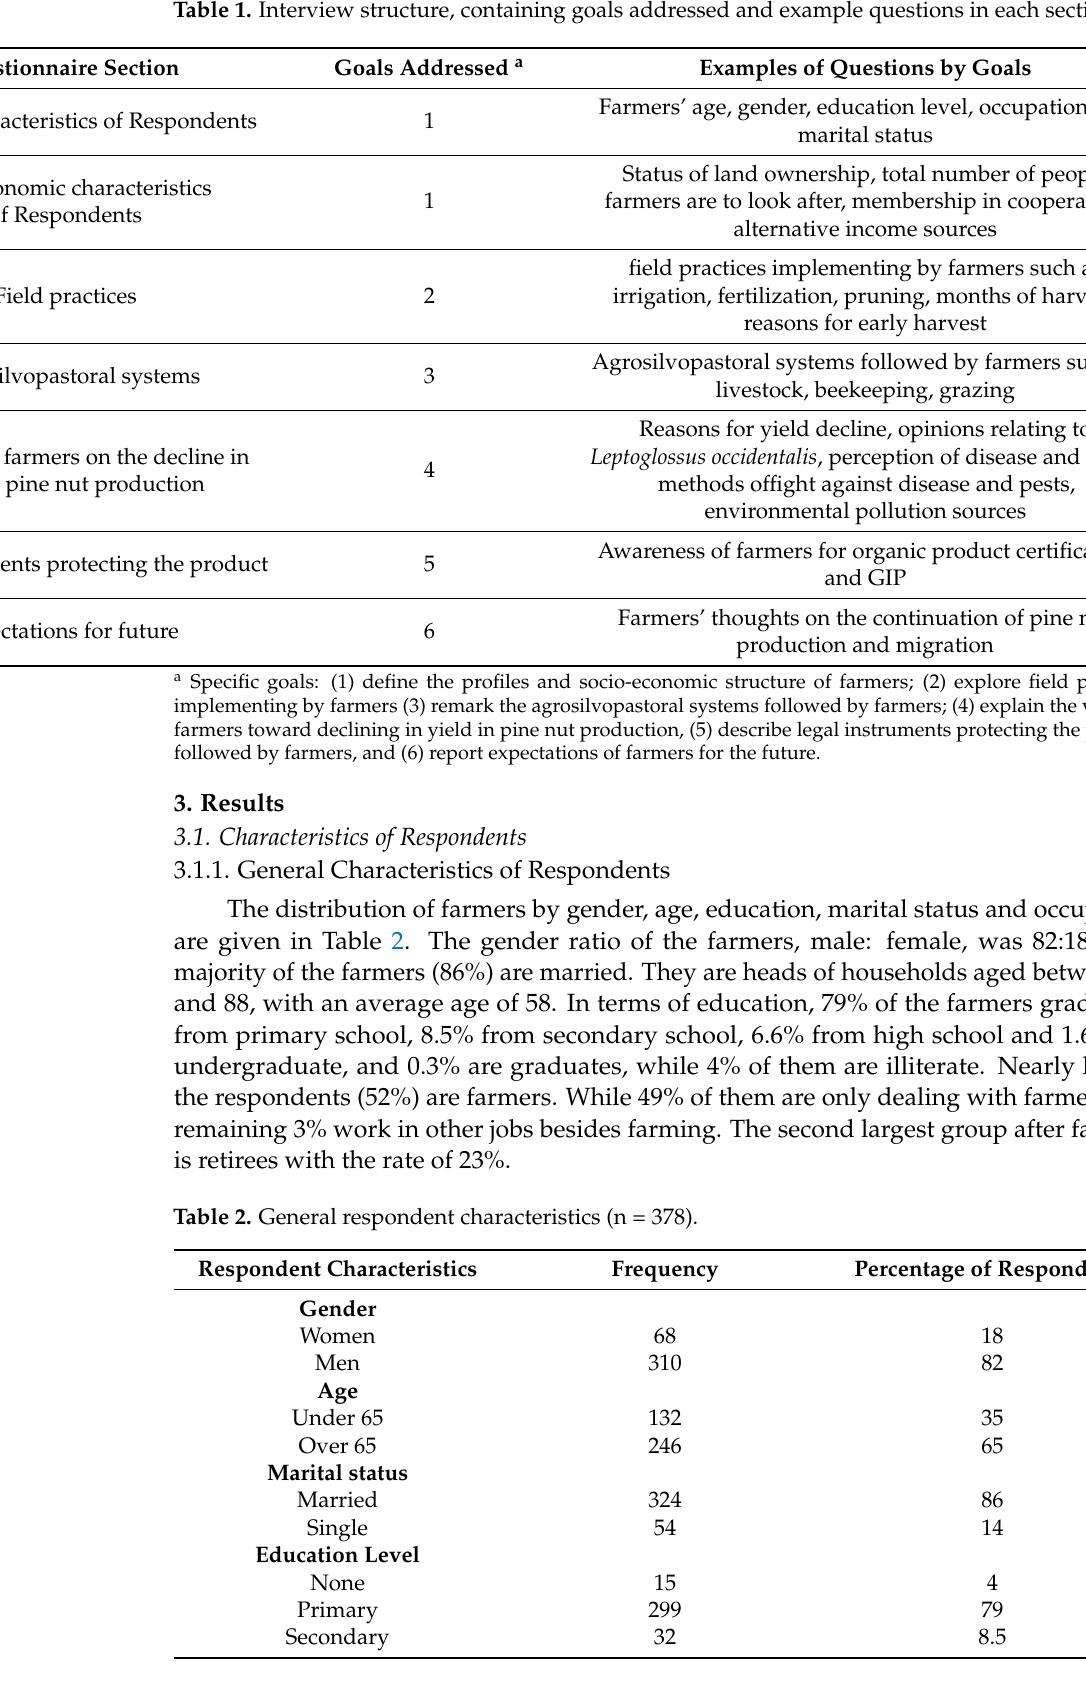
Table 1. Interview structure, containing goals addressed and example questions in each section.